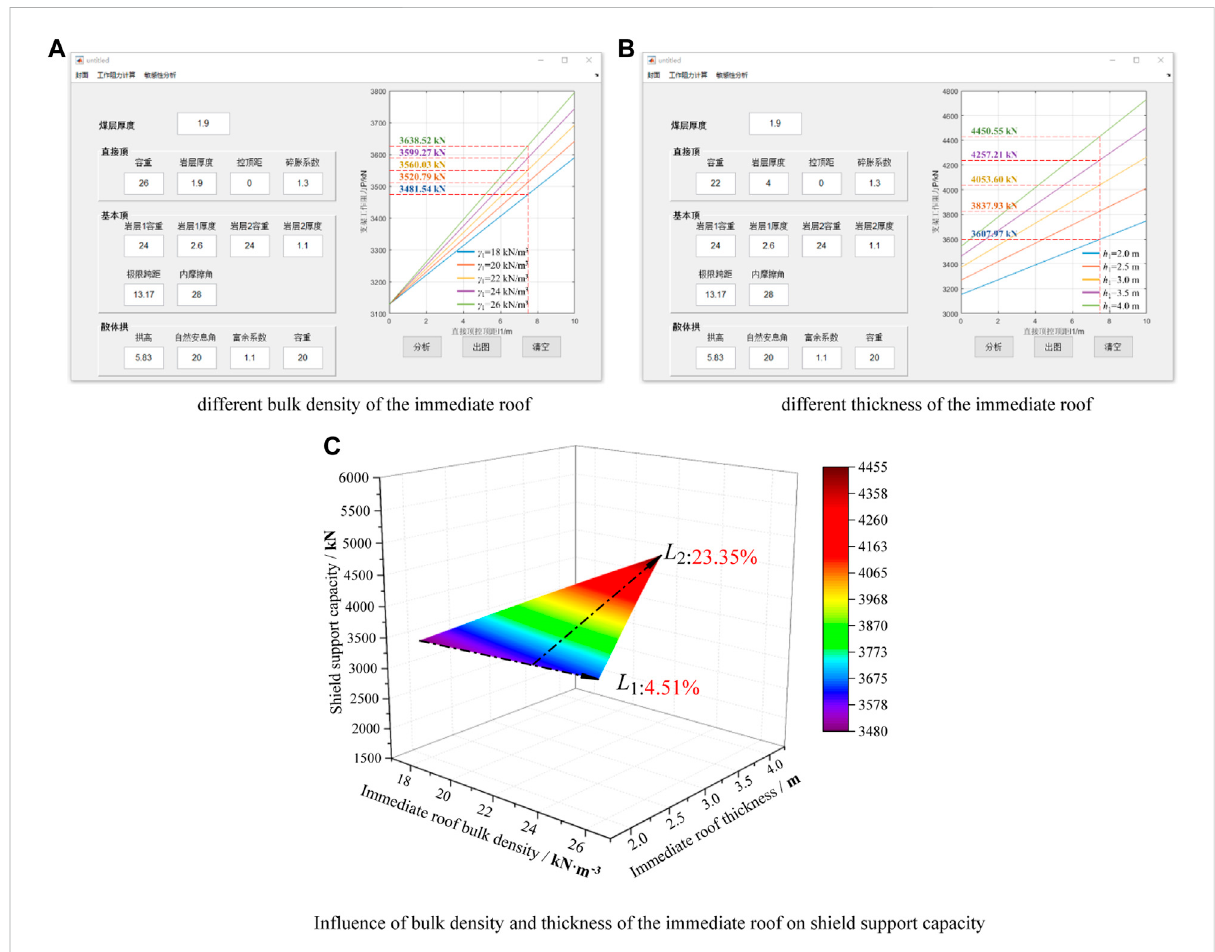
FIGURE 9 Relationship between related parameters of the immediate roof and shield support